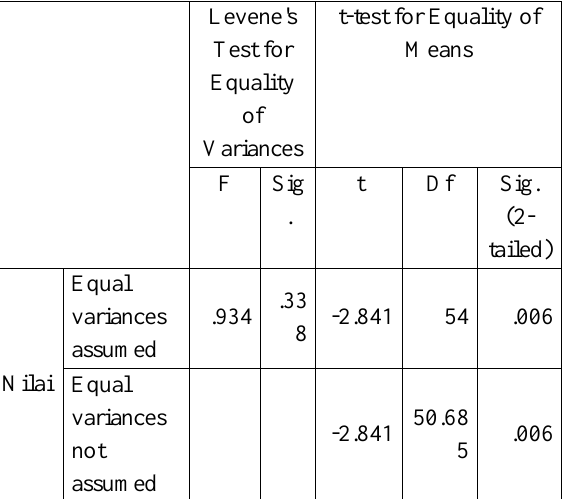
Tabel 4. Uji Beda (Independent Samples